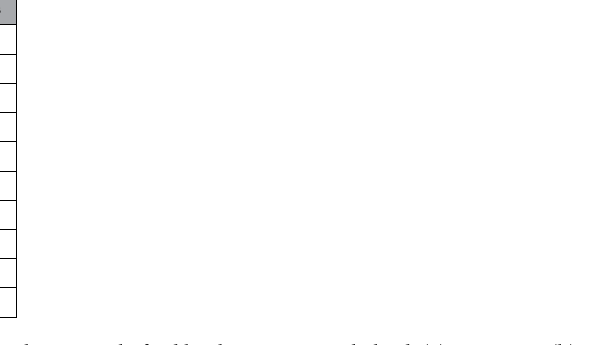
Table 2. Isotherm modeling parameters for the removal of Cd by the MBA nano-hybrid: (a) Langmuir, (b) Freundlich (c) and Temkin. (pH = 7.0, adsorbent = 1.0 g/L, temperature = 25 °C, optimum time = 60 min).